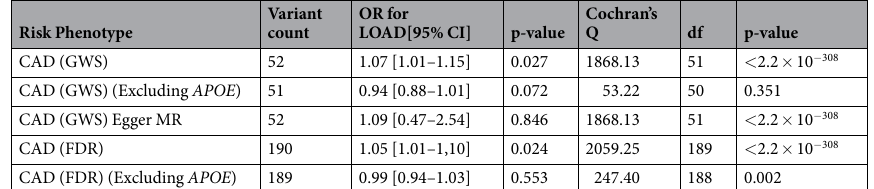
Table 1. Results of Mendelian randomization analysis for CAD on LOAD. Results of the analysis of summary statistics from CAD and LOAD. GWS is Genome Wide Significant (p ≥ 5 × 10 − 8 ); FDR is a false discovery rate of 5%. APOE refers to the rs4420638 variant within the APOE locus.